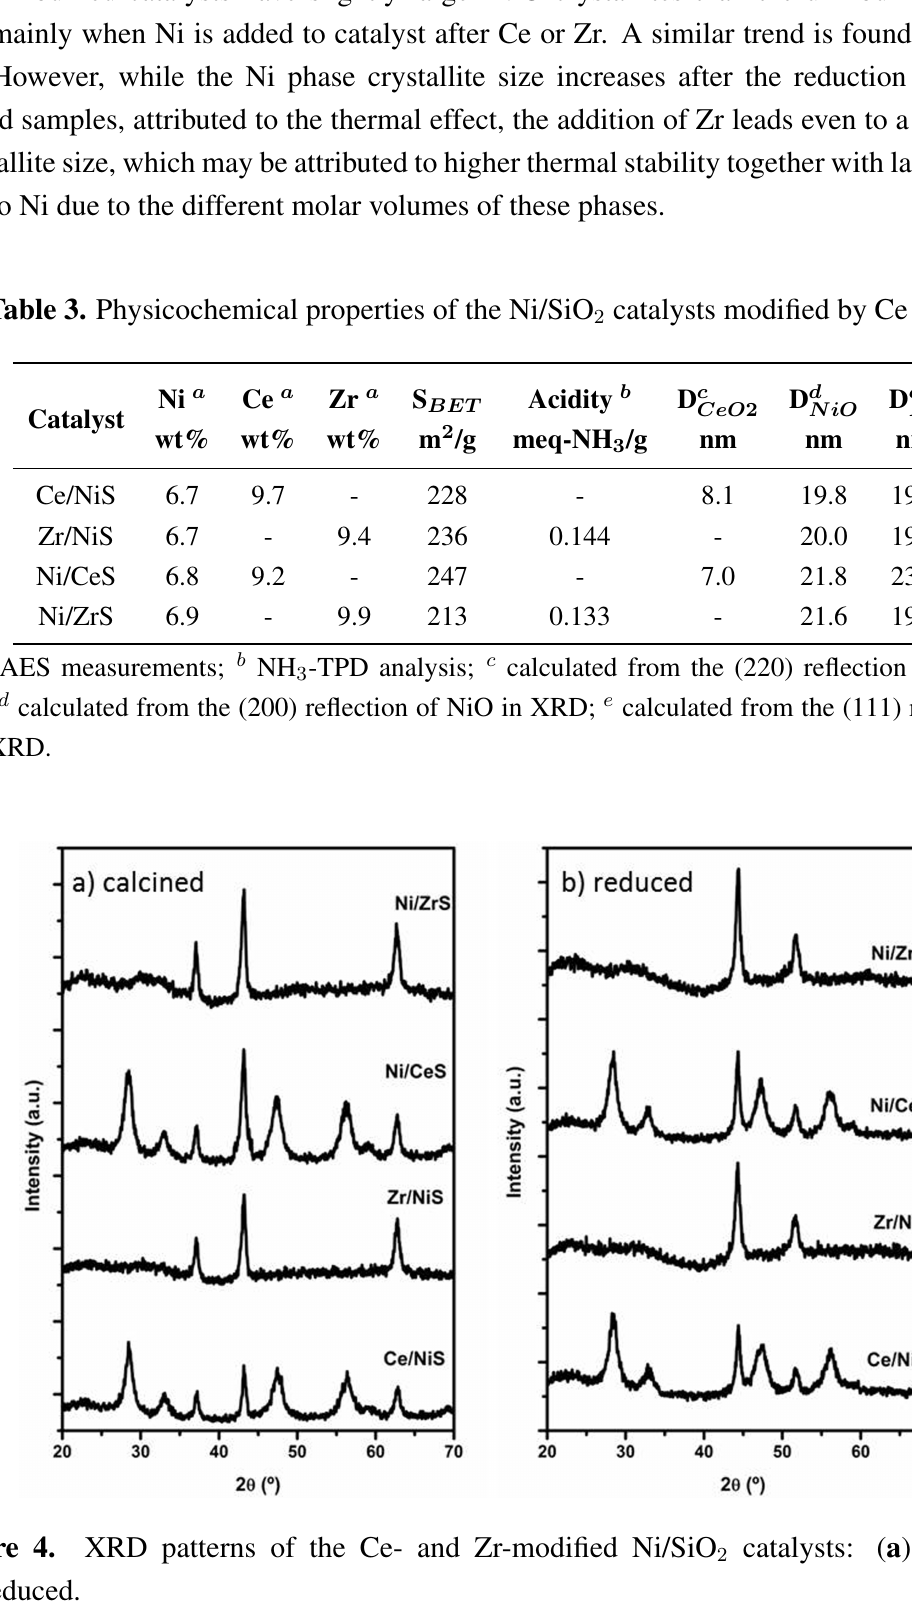
catalysts: ( a ) calcined; 2